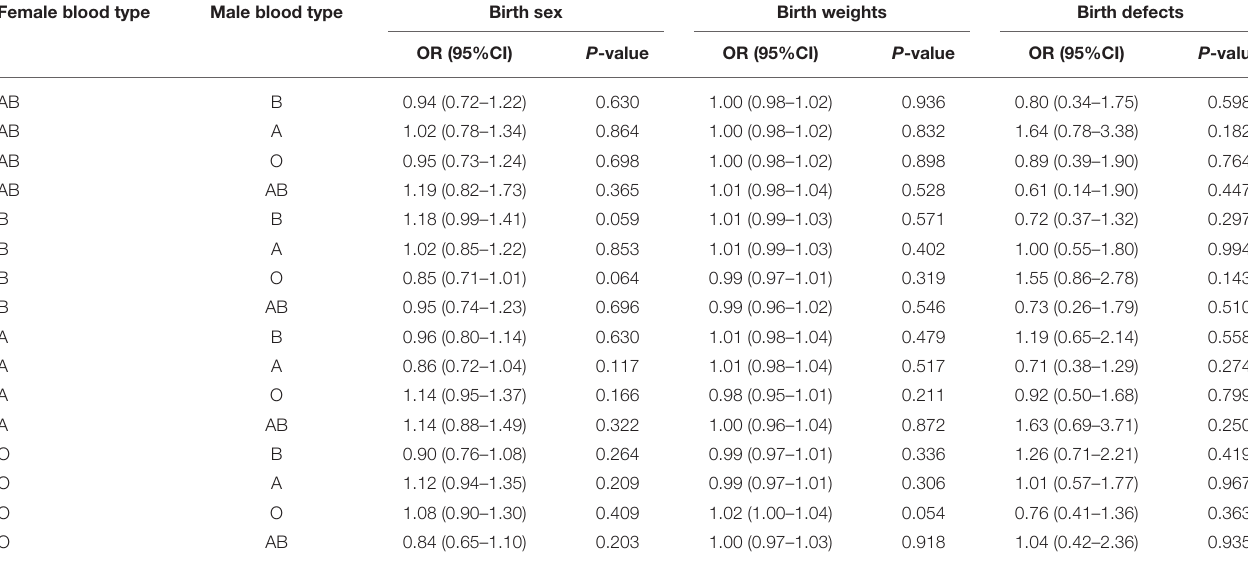
TABLE 5 | Multivariate logistic regression analyses between birth sex, birth weights, birth defects, and parental blood type combinations in single live born cycles. Female blood